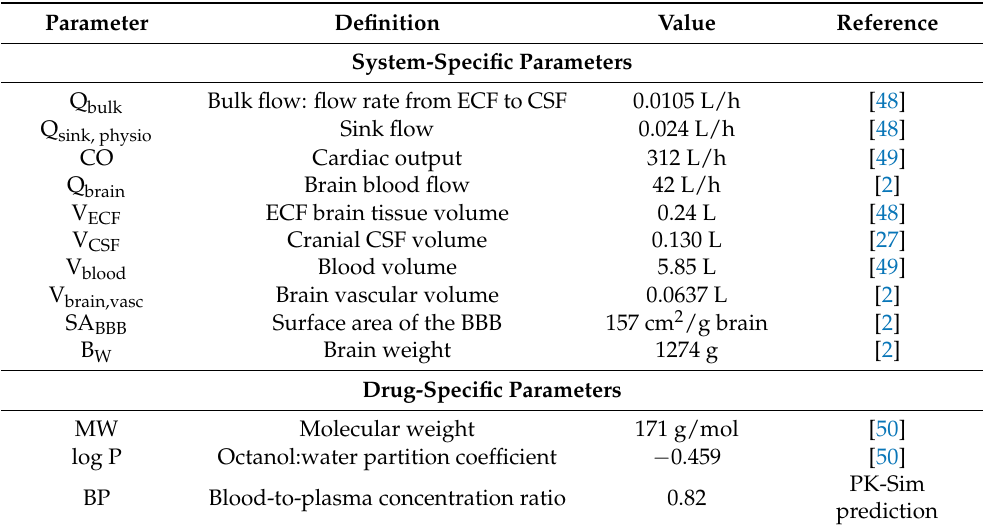
Table 4. Physiological model input